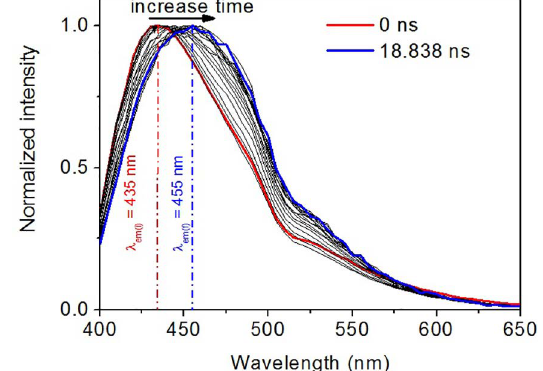
Figure 3. Normalized time-resolved emission spectra (TRES) of C-Dots in diluted aqueous solution ( λ